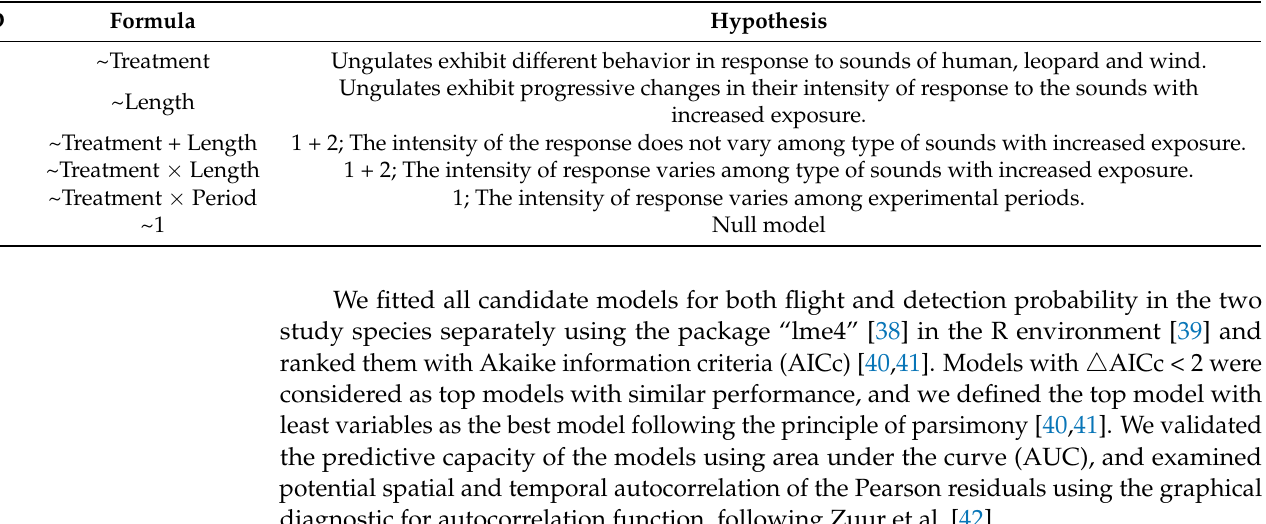
Table 1. Formula and corresponding hypothesis for the candidate